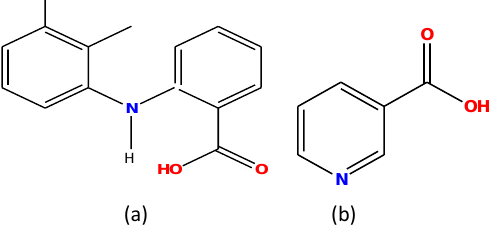
Fig. 1. The chemical structure of MFA (a), and NIC